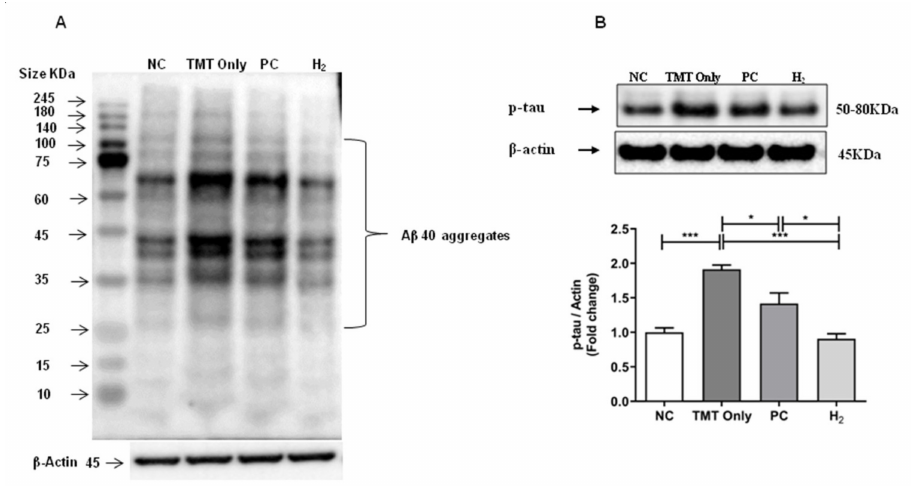
Figure 10. Effects of H 2 gas inhalation treatment on the A β -40 (mouse monoclonal- 32A1) and p-tau-(Ser404) protein levels in brain lysates in TMT-induced C57BL/6 mice after four weeks. ( A ) The antibody-reactive bands of mouse A β -40 in the brain lysates, ( B ) The antibody-reactive band of p-tau-(Ser404) protein levels in brain lysates. The bar graphs represent the band intensity of each protein marker normalized to the total. The data are presented as the mean ± SD of n = 3 mice. Significant differences were analyzed with ANOVA and Tukey’s test. * p < 0.05, *** p < 0.001.